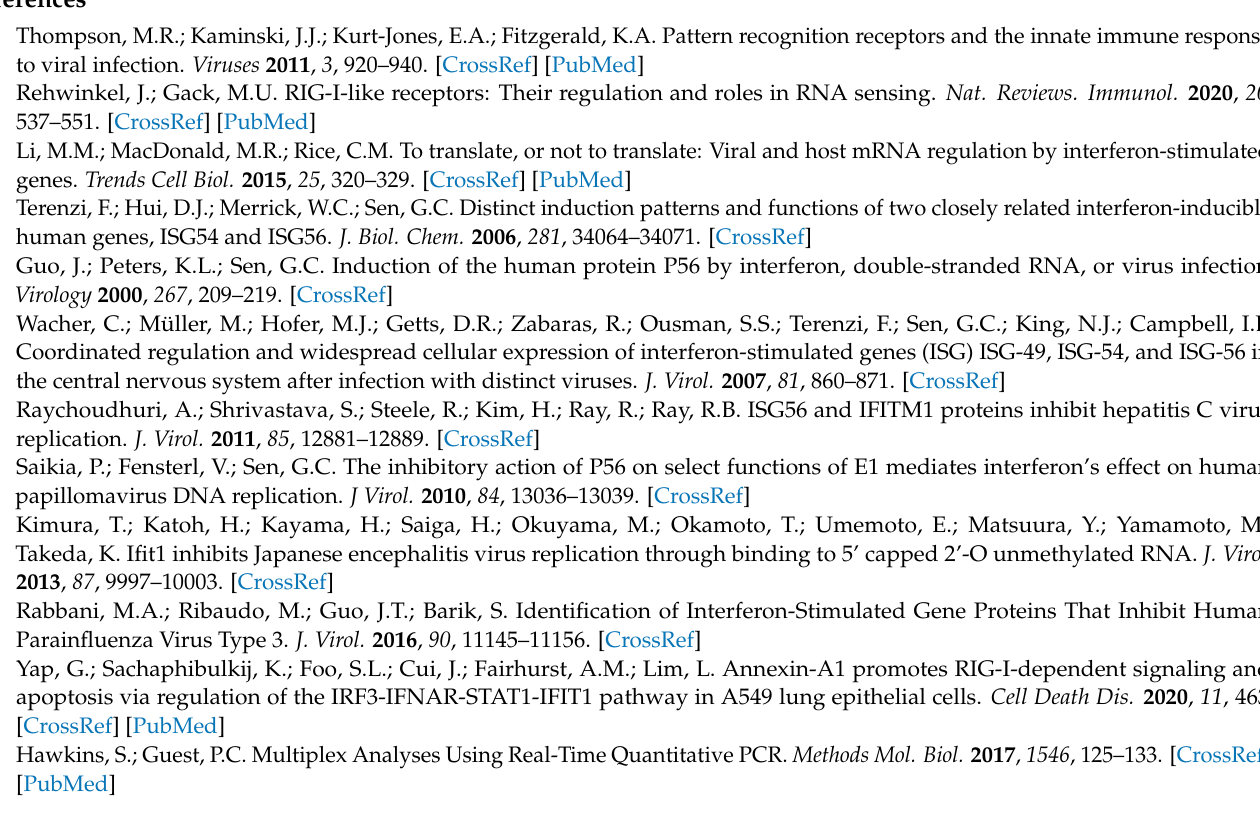
Figure S5: The selected reference genes, GAPDH and ACTB, are in good correlation to each other, Figure S6: Correlation between IFIT-1 and RIG-1 expression with COVID-19 (a), influenza (b), or healthy volunteers (c) at the early phase of illness (3–4 days post symptoms onset), Figure S7: Correlation between IFIT-1 and MDA5 expression with COVID-19 (a), influenza (b), or healthy volunteers (c) at the early phase of illness (3–4 days post symptoms onset), Figure S8: MxA is reliable marker of viral infection